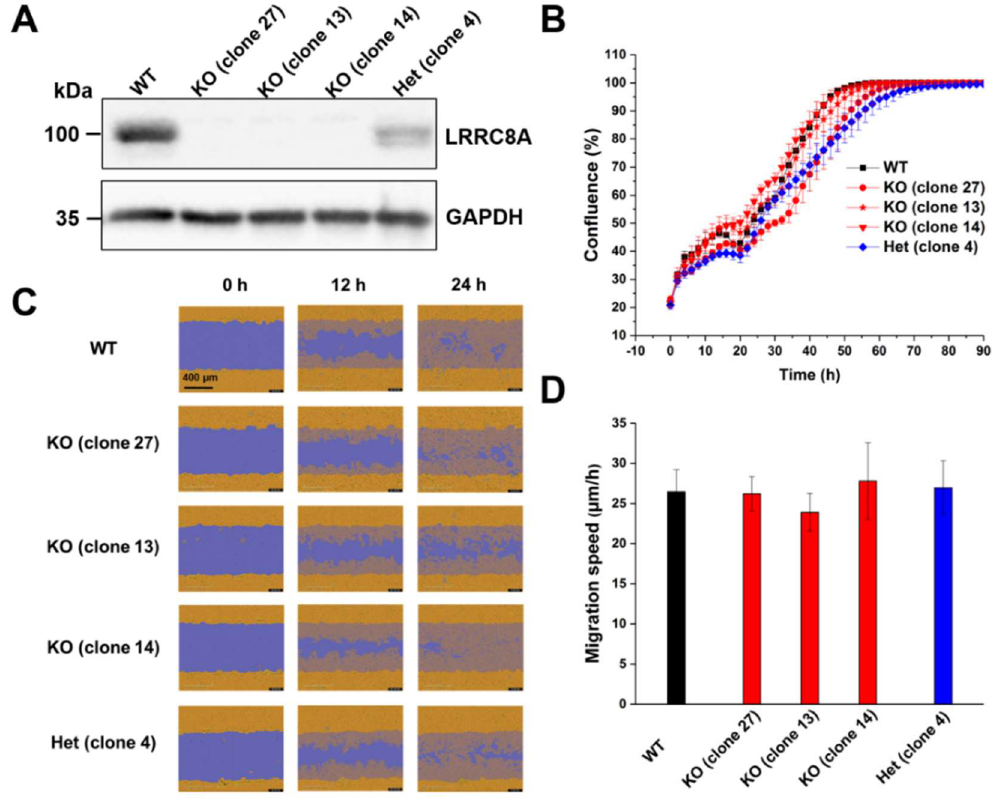
Figure 1. LRRC8A depletion does not affect C2C12 cell proliferation and migration. ( A ) Protein levels of LRRC8A in wild-type (WT), LRRC8A-knockout (KO) and heterozygous (Het) C2C12 cells tested by Western blotting. GAPDH used as loading control. A representative blot of three independent experiments is shown. ( B ) Growth curve of WT, KO, and Het C2C12 cells. Data represent mean ± SD of n = 4 experiments. ( C ) Representative images of the wound healing assay with C2C12 cells at indicated time points. Initial wound mark depicted in blue, cells in orange on blue overlay represents migrated cells. Scale bar, 400 μm. ( D ) Quantification of migration speed of C2C12 cells. Cell migration speed was determined 14 h post-wounding. Data represent mean ± SD of n = 14 experiments.